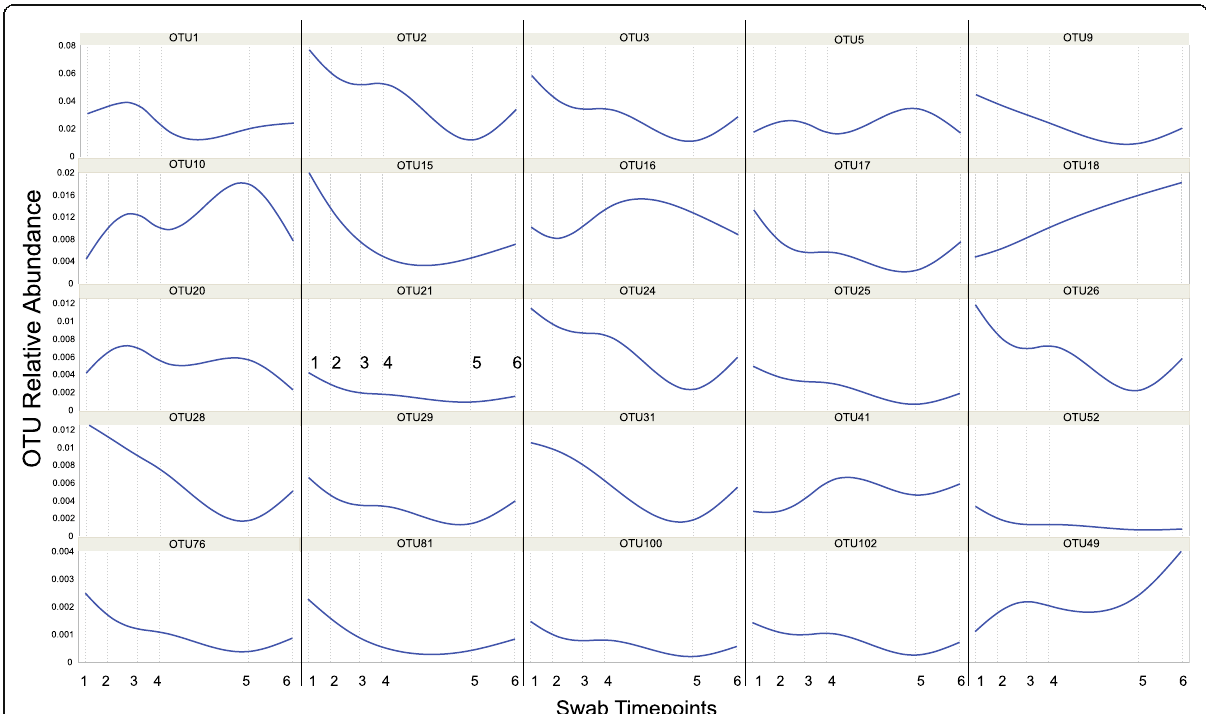
Fig. 5 Core OTUs relative abundances over time using Kernel Smoothing (Loess) estimations. Dashed vertical lines represent sampling time points (days 0, 3, 7, 10, 22, 28 – see Fig. 1). Notice changing y-axes values for relative